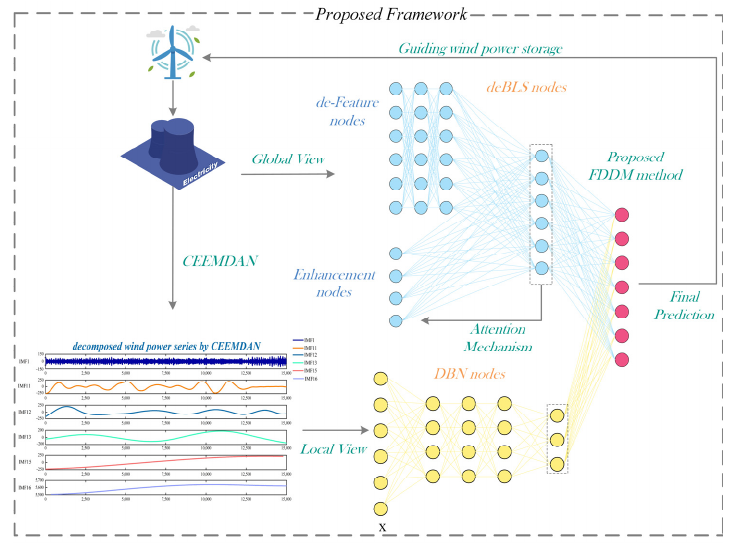
Figure 1. MVEW ‐ DNN consists of the CEEMDAN ‐ DBN, deBLS, and FDDM. deBLS is established Figure 1. MVEW-DNN consists of the CEEMDAN-DBN, deBLS, and FDDM. deBLS is established for for the global view. CEEMDAN ‐ DBN is established for the local view. the global view. CEEMDAN-DBN is established for the local